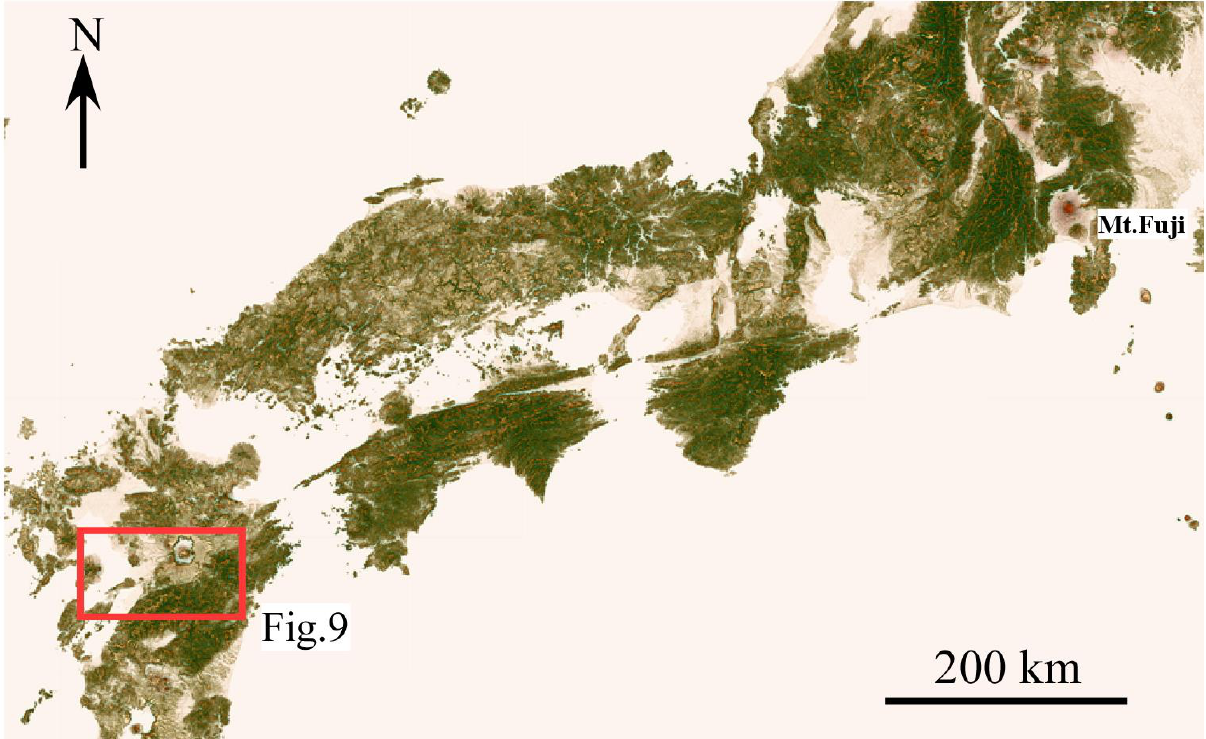
Figure 8. Topography of South Western Japan, made from GTOPO30.